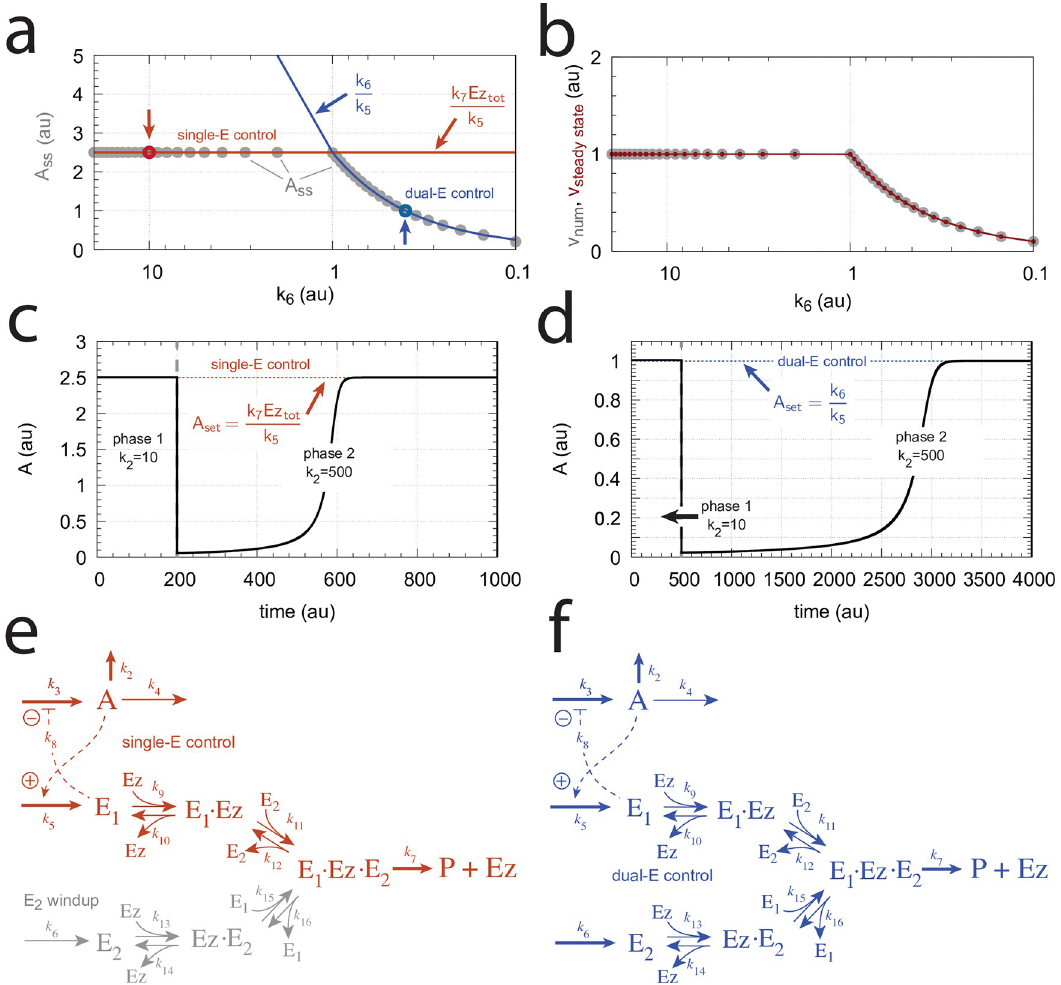
Fig 9. Switch between dual-E and single-E control in the motif 2 antithetic controller with a random-order ternary-complex mechanism removing E 1 and E 2 (Fig 5). (a) A ss (steady state in A) as a function of k 6 . Red and blue lines indicate the respective set- point values for single-E and dual-E control. Gray solid points show the numerically calculated steady state levels. The outlined red and blue circles (indicated by the vertical arrows) show the k 6 values (10.0 and 0.4) used in panels c and d when changes in k 2 are applied. (b) Steady state values of v (Eq 13) obtained by the King-Altman method (inner red dots, S1 Text) and numerically calculated velocities (gray dots). (c) and (d) Single-E and dual-E control when k 6 values are respectively 10.0 and 0.4, and k 2 changes step-wise from 10.0 to 500. Other rate constants: k 3 =1 × 10 5 , k 4 =1.0, k 5 =0.4, k 7 =1 × 10 6 , k 8 =0.1, k 9 =1 × 10 8 , k 10 =1 × 10 3 , k 11 =1 × 10 8 , k 12 =1 × 10 3 , k 13 =1 × 10 8 , k 14 =1 × 10 3 , k 15 =1 × 10 8 , k 16 =1 × 10 3 . Initial concentrations, panel c: A 0 =2.5, E 1,0 =363.5, E 2,0 =4.5 × 10 4 , Ez 0 =3.04 × 10 − 13 , (E 1 � Ez) 0 =4.3 × 10 − 13 , (E 1 � Ez � E 2 ) 0 =1.0 × 10 − 6 , (Ez � E 2 ) 0 =2.7 × 10 − 11 . Initial concentrations, panel d: A 0 =1.0, E 1,0 =905.3, E 2 is continuously increasing (wind-up). (f) In dual-E control the entire network participates in the control of A (outlined in